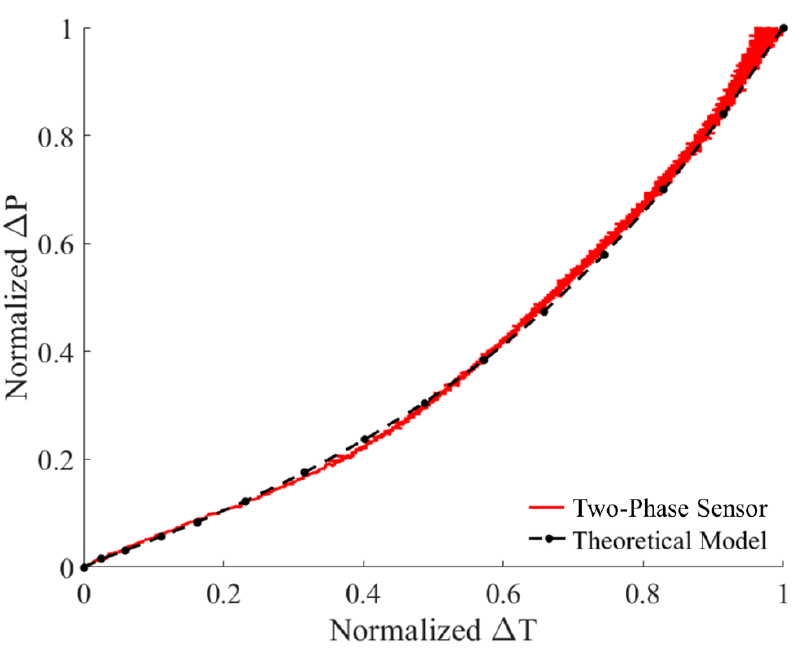
Figure 6. Normalized pressure and temperature change measurements for the prototype sensor compared to theoretical results.